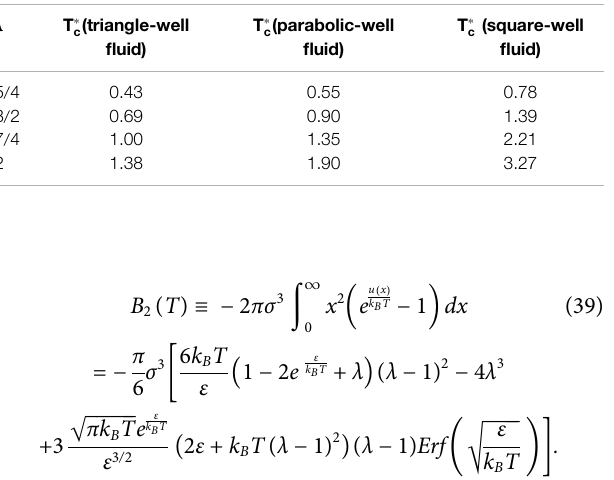
TABLE 2 | Estimates of the reduced critical temperatures T p c ≡ k B T c / ε (up to three signi fi cant fi gures) of triangle-well, parabolic-well, and square-well fl uids for variousvaluesoftherange λ ,asobtainedfromthesecondvirialcoef fi cientandthe use of the Vliegenthart and Lekkerkerker